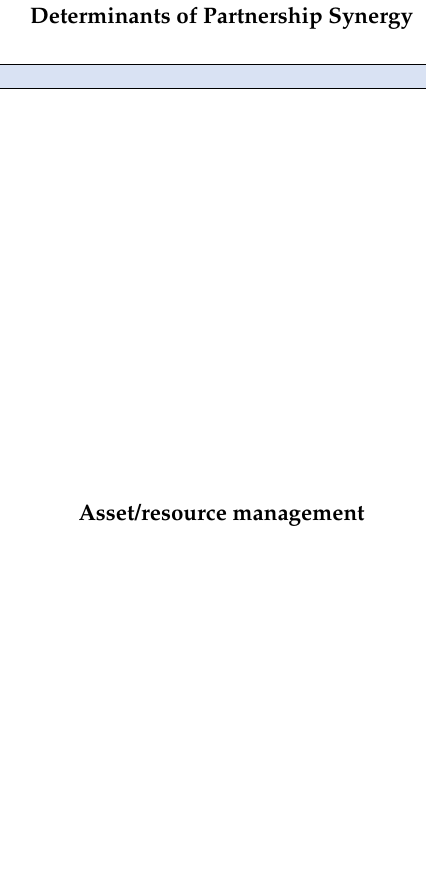
Phase I Qualitative Findings Phase II Quantitative Results Based on 14 Meeting Observations and 16 Based on Survey of 54 Partnership Interviews in Two Multi-Stakeholder Stakeholders Representing Five Partnerships Multi-Stakeholder Partnerships Partnership Enabling